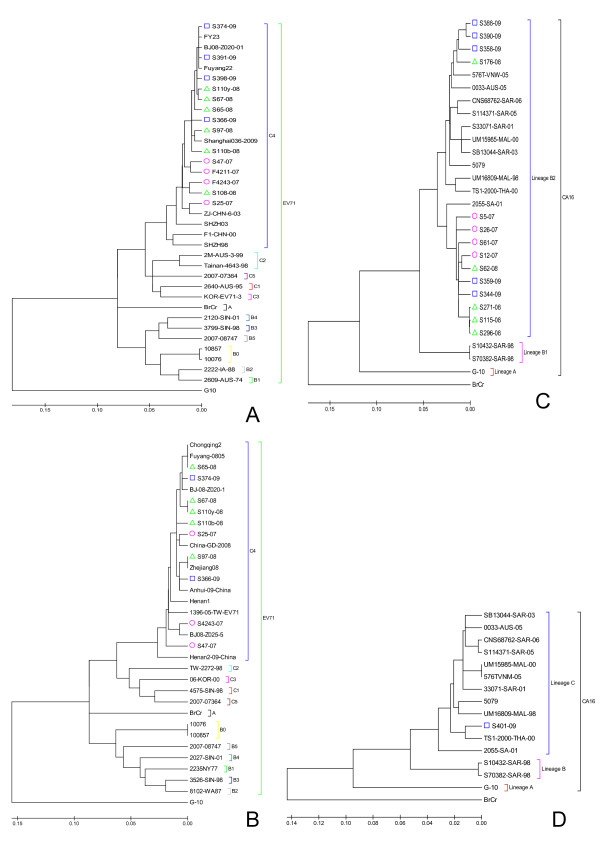
Phylogenetic analysis based on EV71 vp1s (A), EV71 vp4s (B), CA16 vp1s (C) and CA16 vp4s (D). The unrooted phylogenetic trees were generated by the neighbor-joining method on the basis of a multiple alignment of the nucleotide sequences of EV71 vp1s, EV71 vp4s, CA16 vp1s and CA16 vp4s. The sequences in the dendrograms marked by red circle (○), green triangle (Δ) and blue square (□) were isolated in this research (additional file 2) while other sequences were obtained from GenBank (additional file 1). CA16 strain G-10 was used as an outgroup in Figure 1A and Figure 1B while EV71 strain BrCr was used as an outgroup in Figure 1C and Figure 1D.